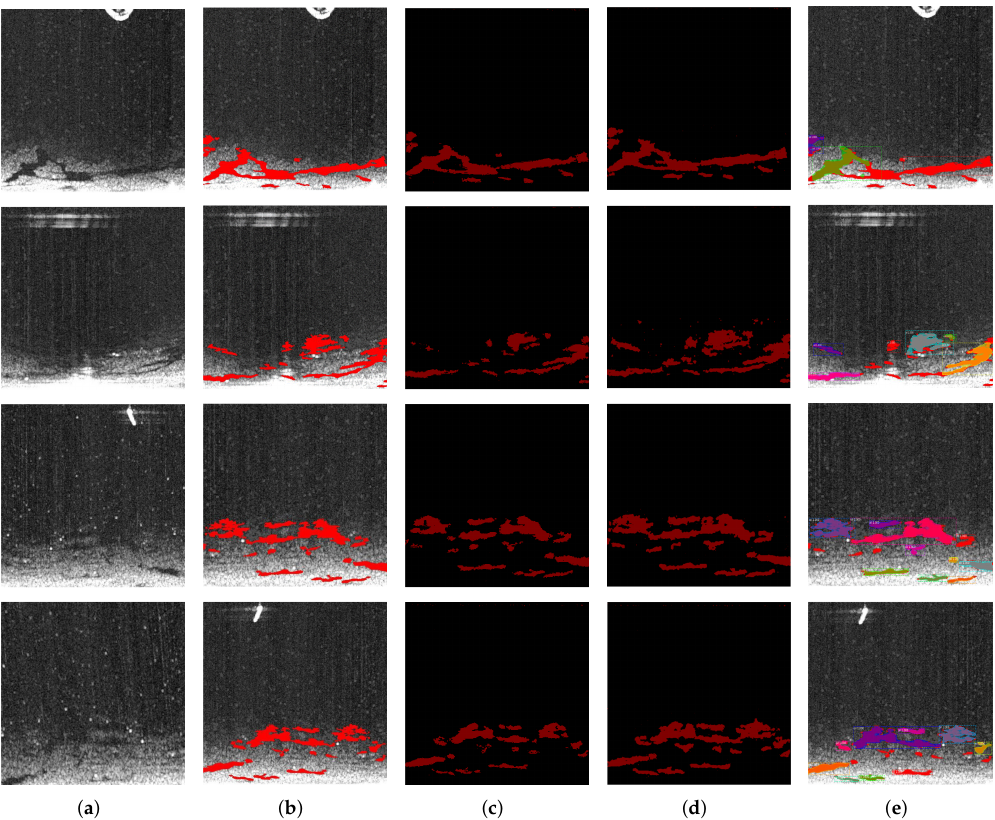
Figure 11. The segmentation results of different backbones with soft attention experiments: ( a ) The image, ( b ) ground truth, ( c ) result of the VGG + soft attention + FCN, ( d ) result of Resnet50 + soft attention + FCN, and ( e ) FPN + soft attention +